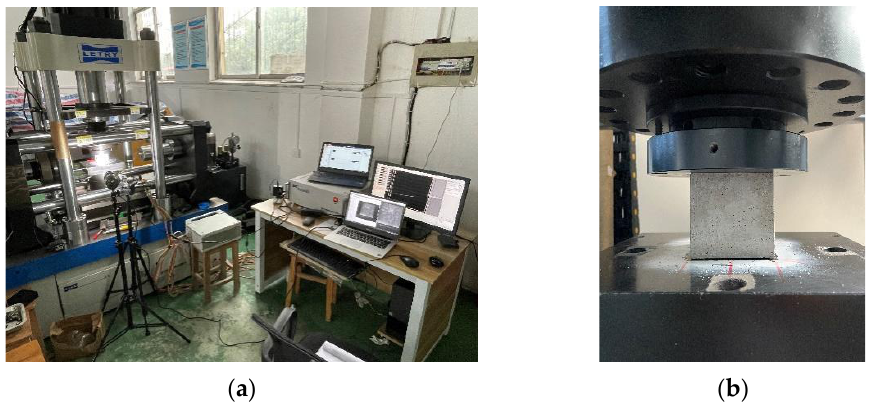
Figure 2. Test equipment and loading schematic diagram. ( a ) Loading equipment and industrial camera; ( b ) loading schematic diagram.